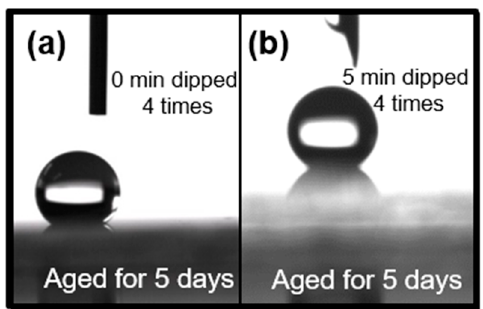
Figure 10. Water drops’ images on the coatings using a dipping rate of 1000 mm/min.